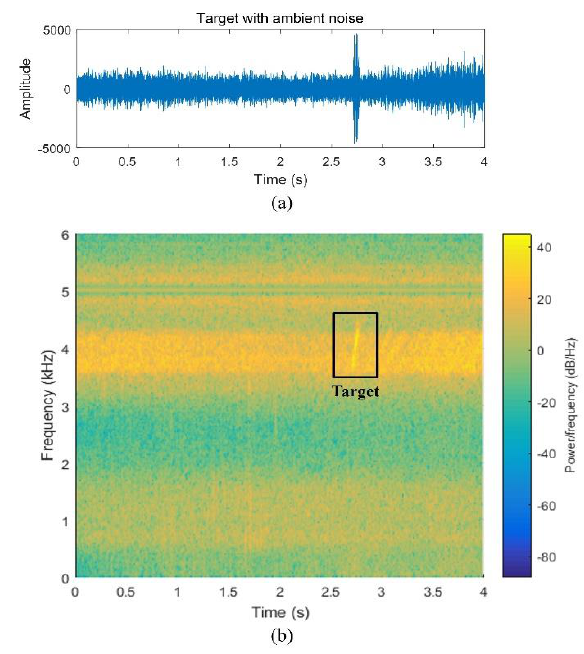
Figure 11. Example of the target data spectrogram: ( a ) beamforming output; ( b ) spectrogram.